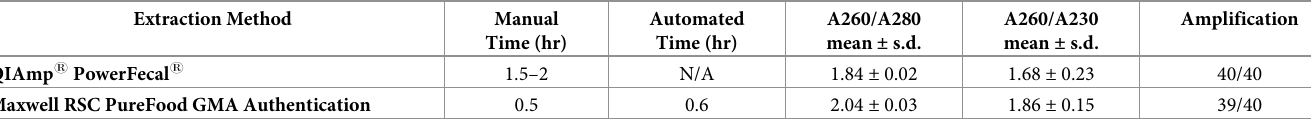
Table 1. Comparison of DNA extraction